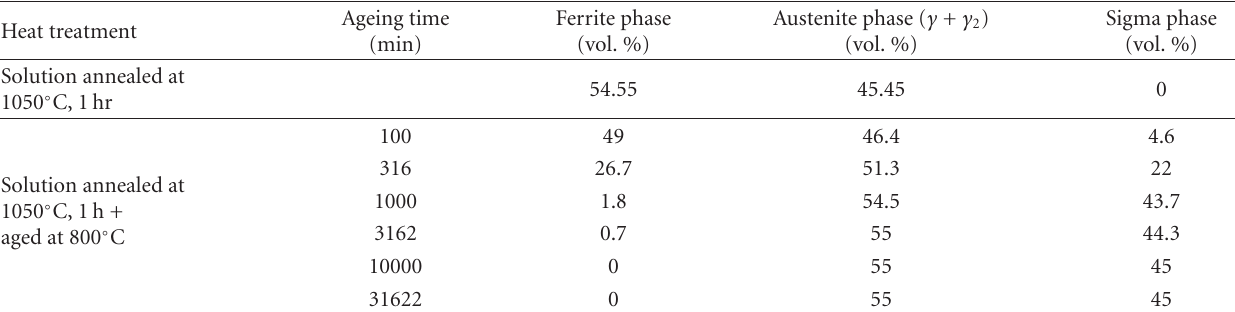
Table 2: The phase volume percentages obtained from digital image analysis.